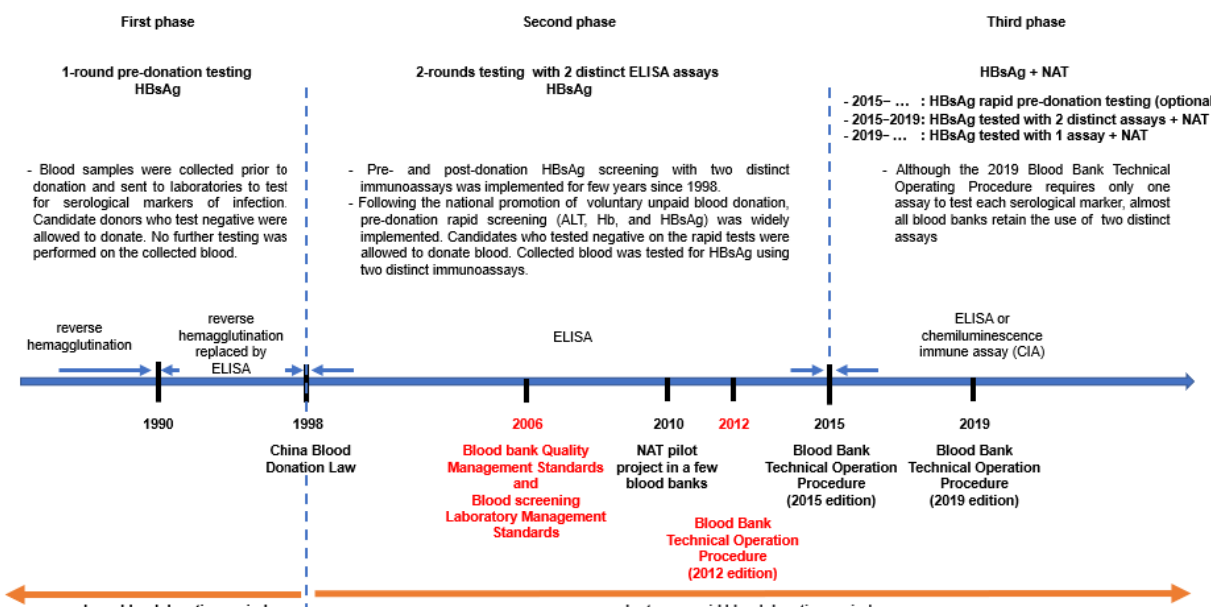
Figure 1. History of HBV screening in Chinese blood donors.